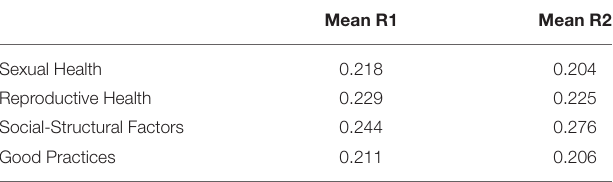
TABLE 5 | Mean values for the coefficient of variation by round and dimension.